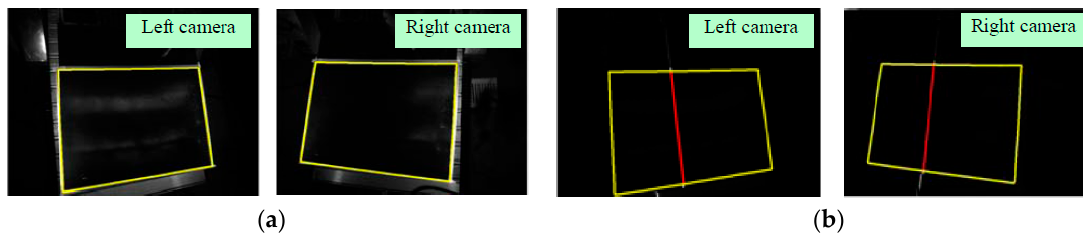
Figure 15. Images captured by the left and right cameras. ( a ) Global boundary obtained with a long